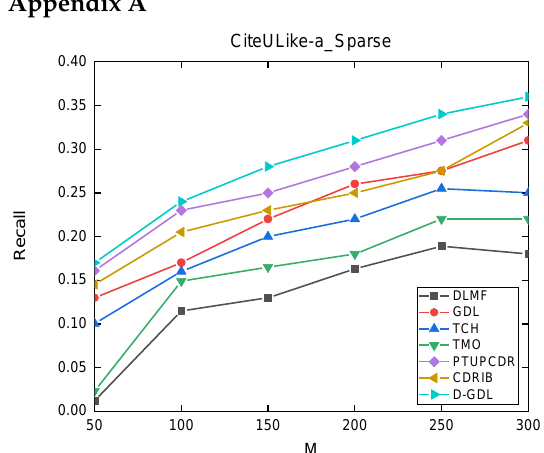
Figure A1. Performance of D-GDL against the comparative approaches based on Recall vs. M for CiteULike-a Dataset in the Sparse Setting.